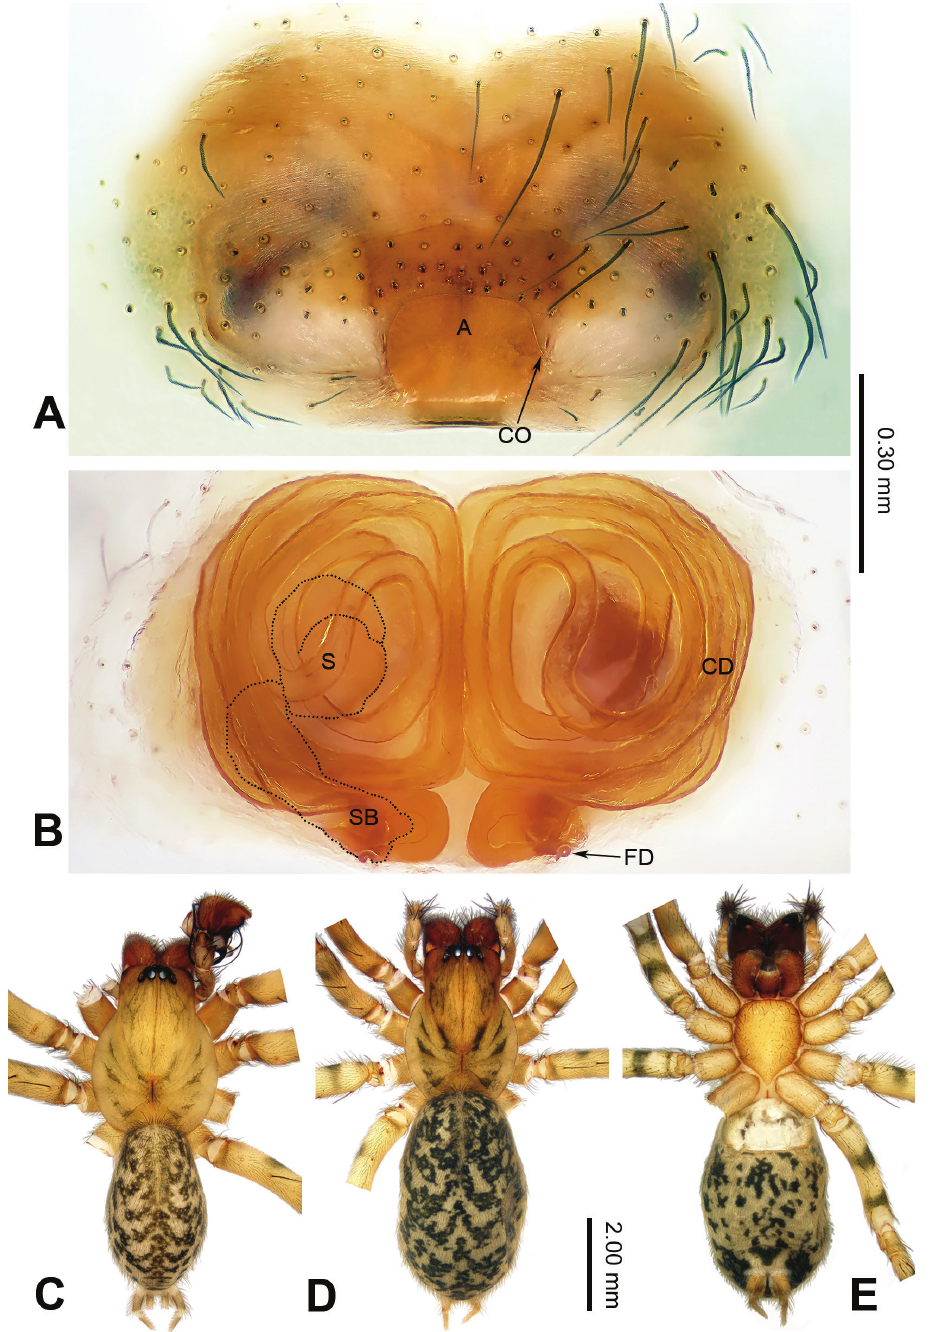
Figure 4. Epigyne and habitus of Guilotes qingshitanensis sp. n. A Epigyne, ventral B Vulva, dorsal C Male habitus, dorsal D Female habitus, dorsal E Female habitus, ventral. Scale bars equal for C–E